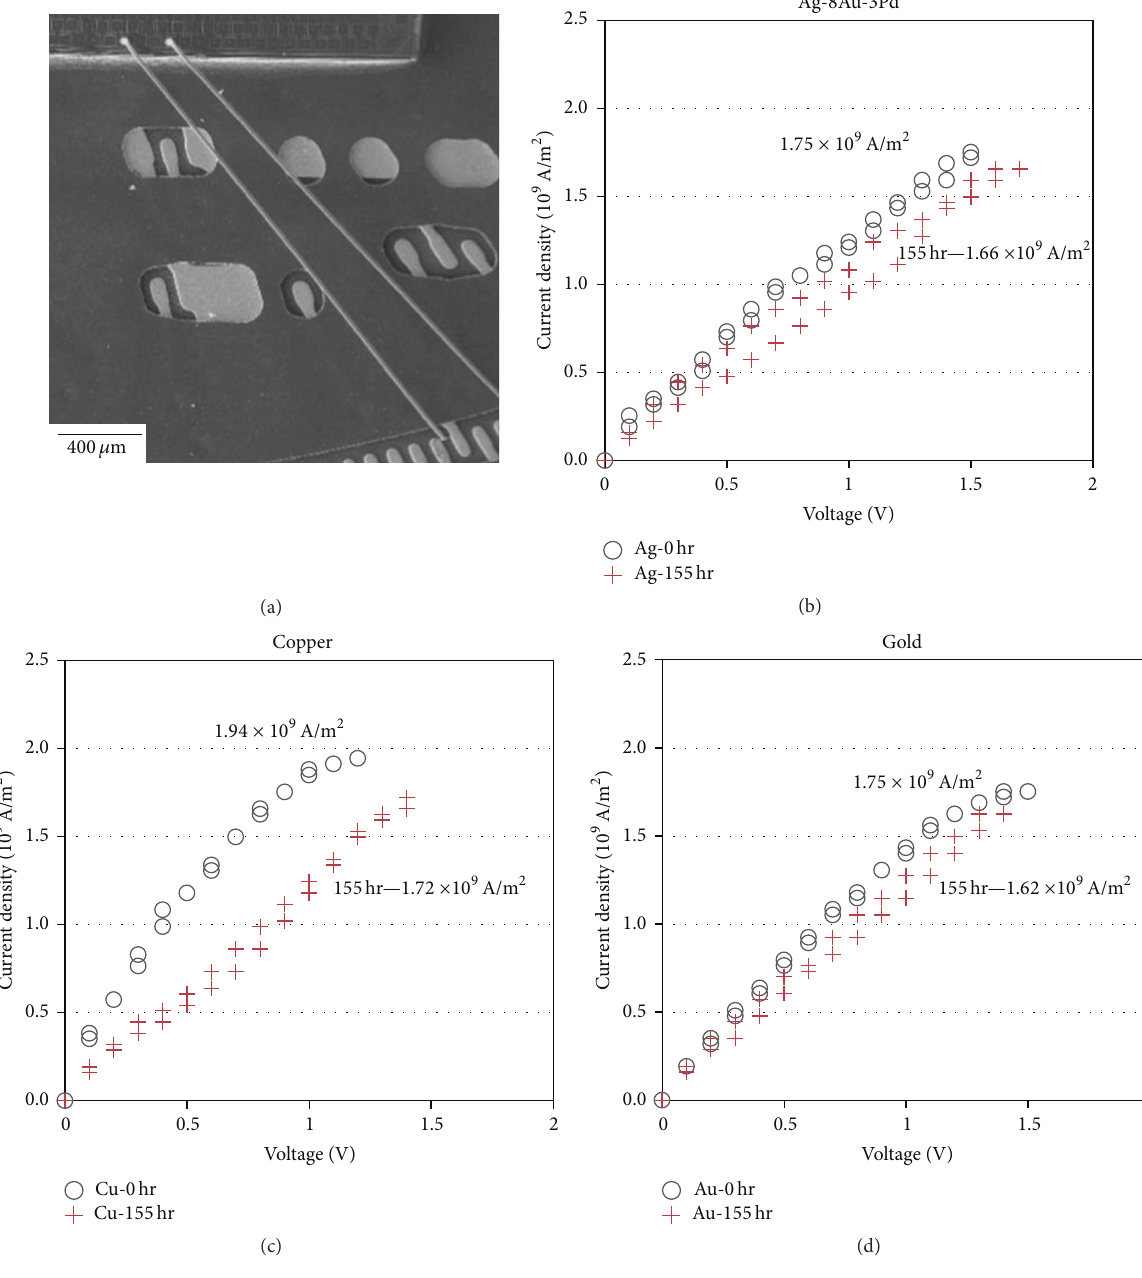
Figure 3: (a) I-V curve method and the results of (b) Ag-8Au-3Pd, (c) copper, and (d) gold